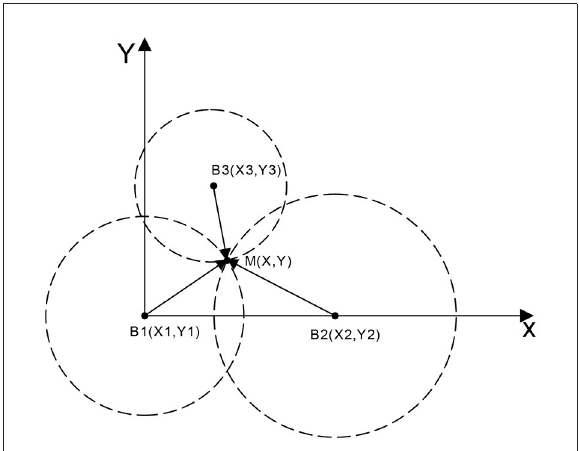
FIGURE1 TOA positioning method. M represents the positioning tag, B i indicates the base station node, and the distance between M to each base station is denoted d i